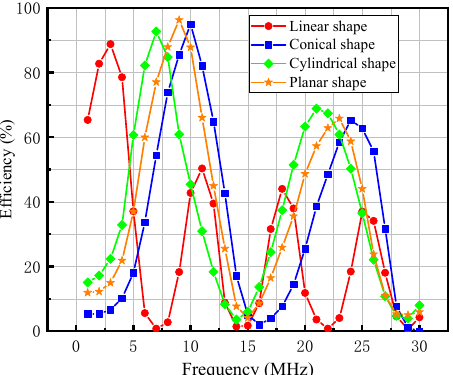
Figure 9. Electric field modulus of four kinds of transfer structures: ( a ) Linear; ( b ) Conical; ( c ) Cy- lindrical; ( d ) Planar.